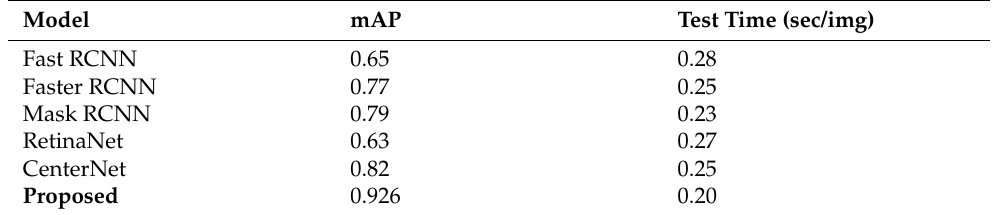
Table 5. Comparative assessment of the presented model with object-recognition frameworks.